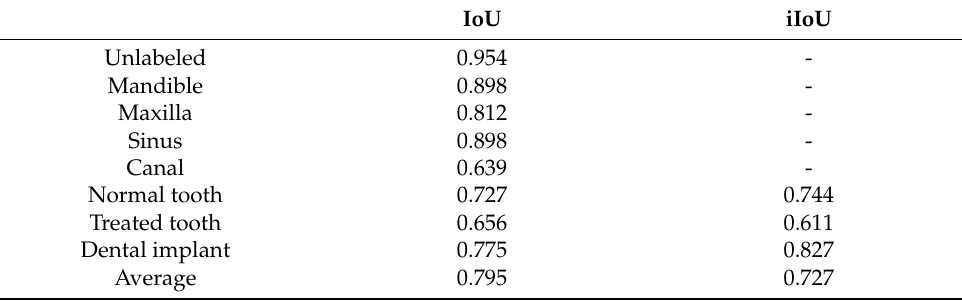
Table 2. Intersection over union (IoU) and instance-level IoU (iIoU) for each